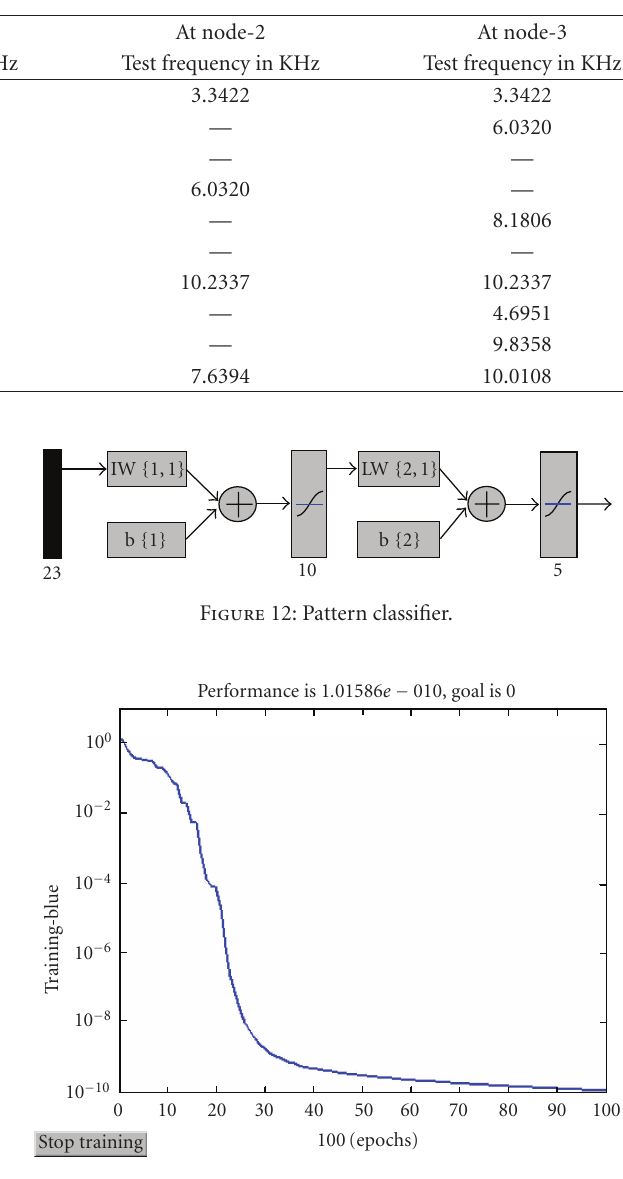
Table 7: Test frequencies of the multiple faults (dashes mean no access to nodes).